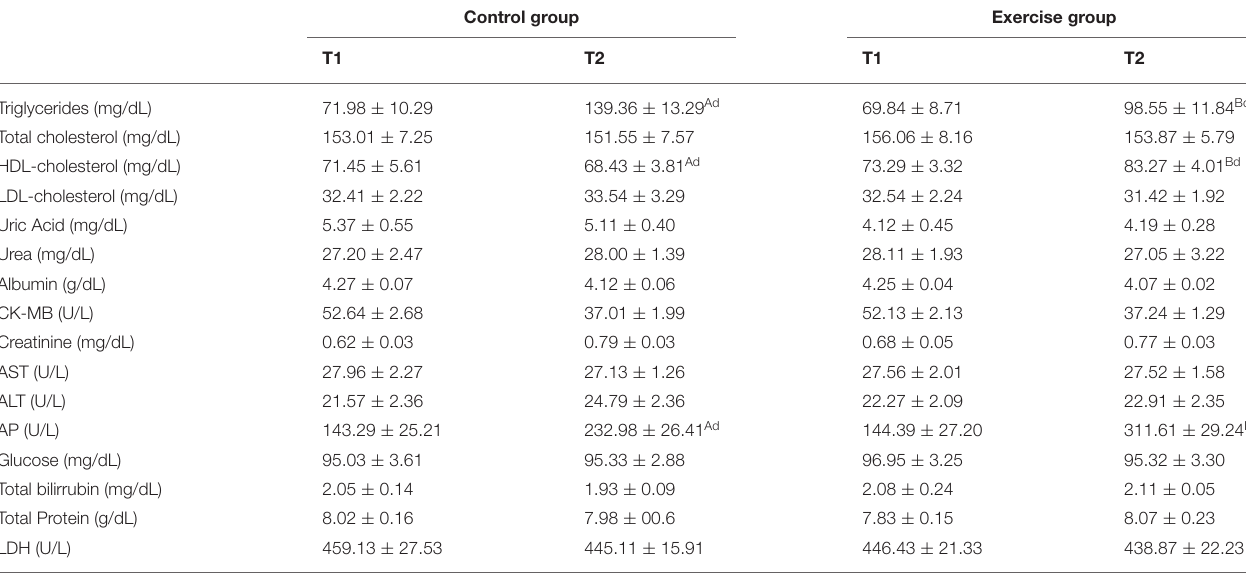
TABLE 5 | Biochemical parameters from the control and exercise groups.